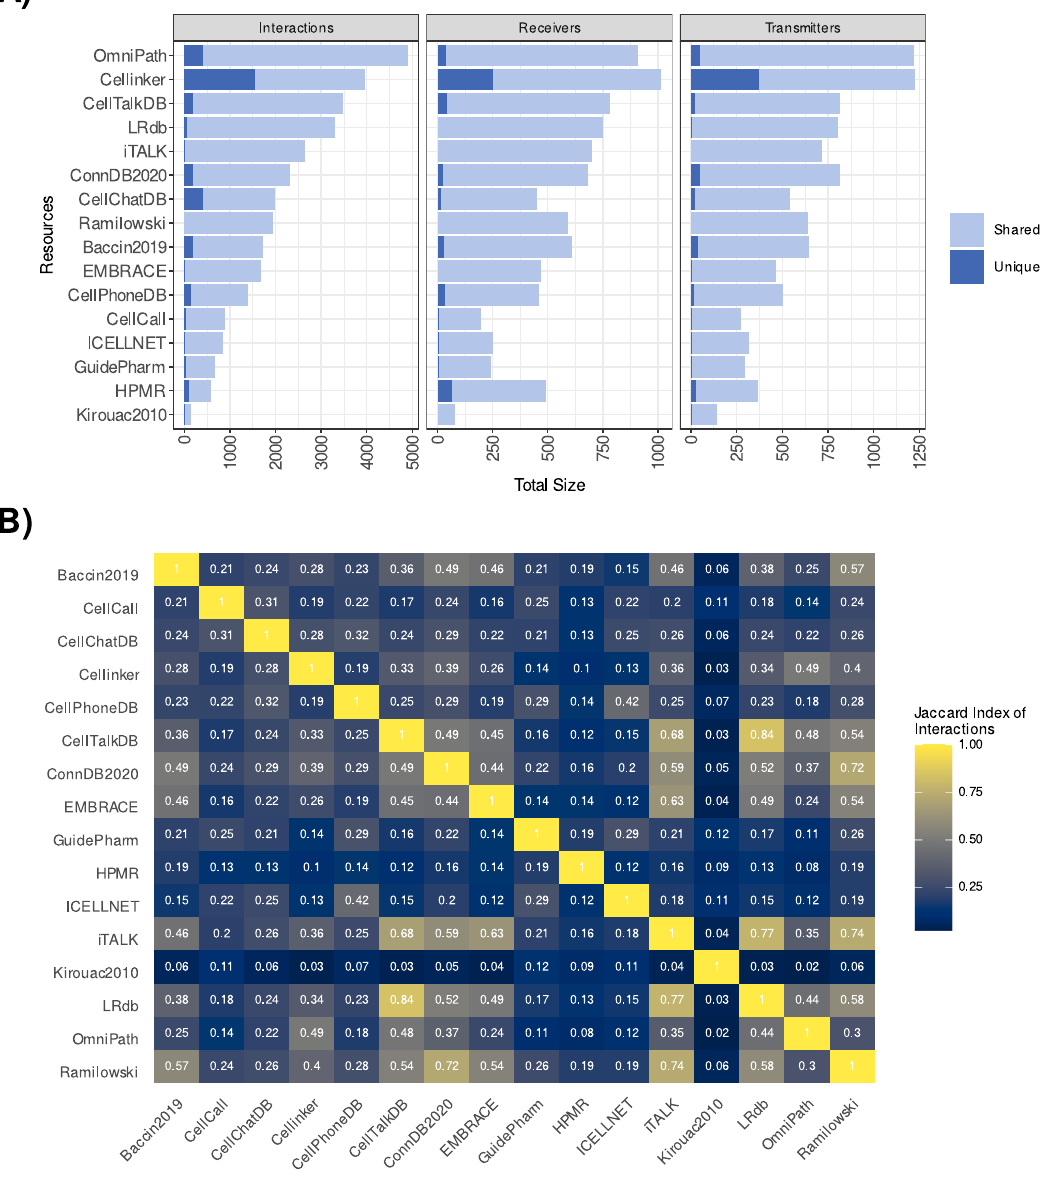
Fig. 3 Cell-cell communication resources — uniqueness and overlap. A Shared and unique Interactions, Receivers and Transmitters for each resource. B Similarity between the different resources based on the interactions (Jaccard Index). Source data are provided as a Source Data fi